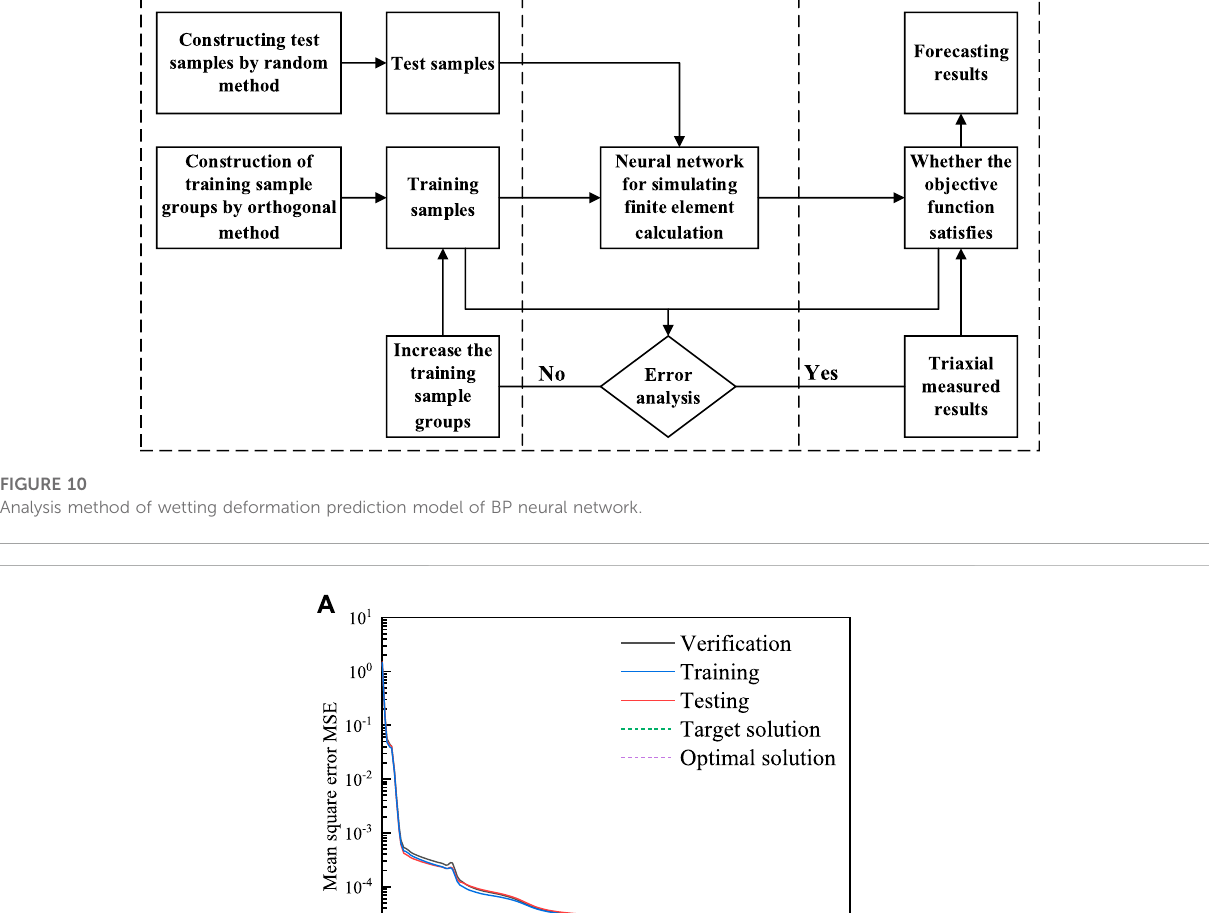
Frontiers in Earth